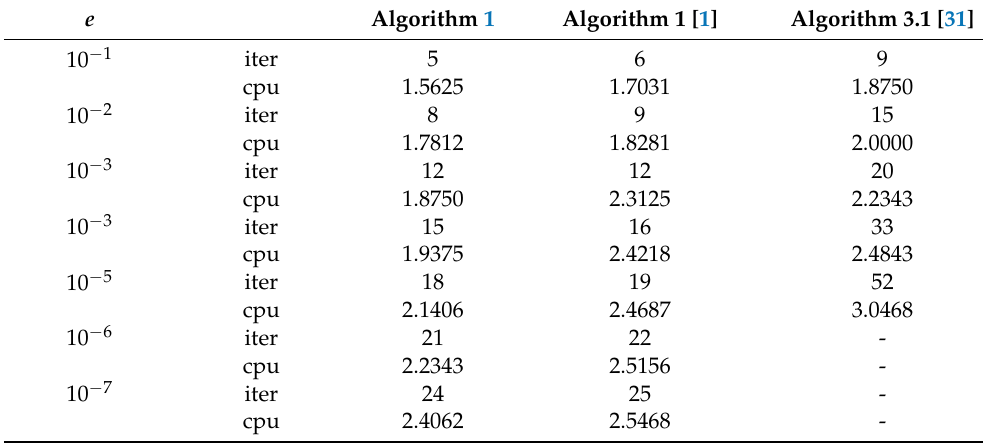
Table 3. Comparison of numerical results of Algorithm 1, Algorithm 1 [1], Algorithm 3.1 [31] in Example